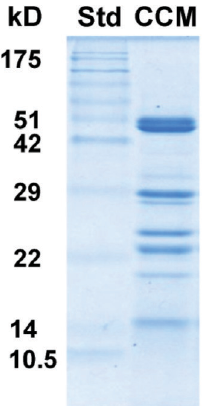
FIGURE 1 - SDS-PAGEgel electrophoresis from standard marker protein (Bio-Rad, USA) and CCM. Lane 1 is MW